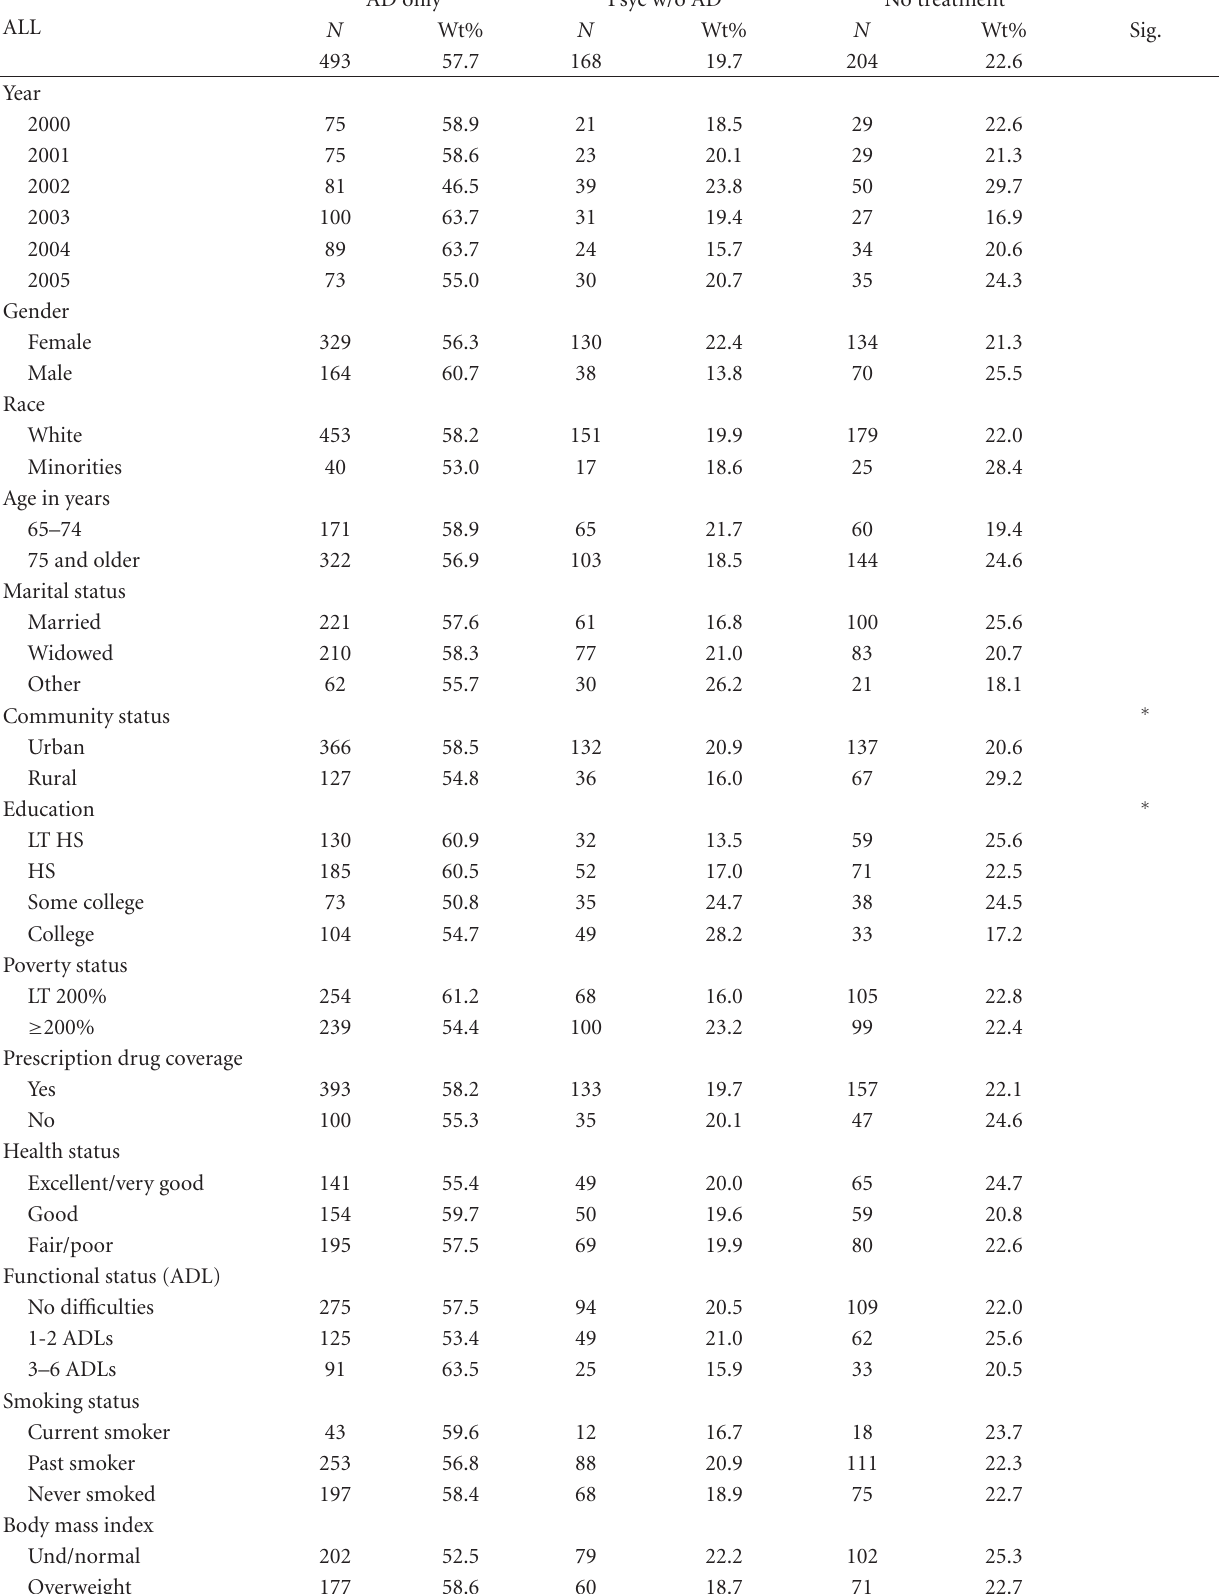
Table 2: Number and weighted percent of study sample by depression treatment. Medicare Current Beneficiary Survey,